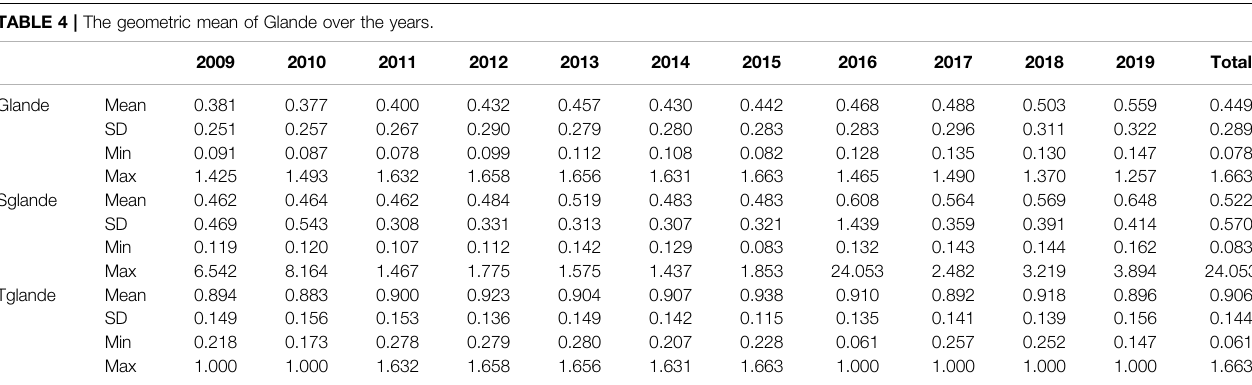
TABLE 4 | The geometric mean of Glande over the